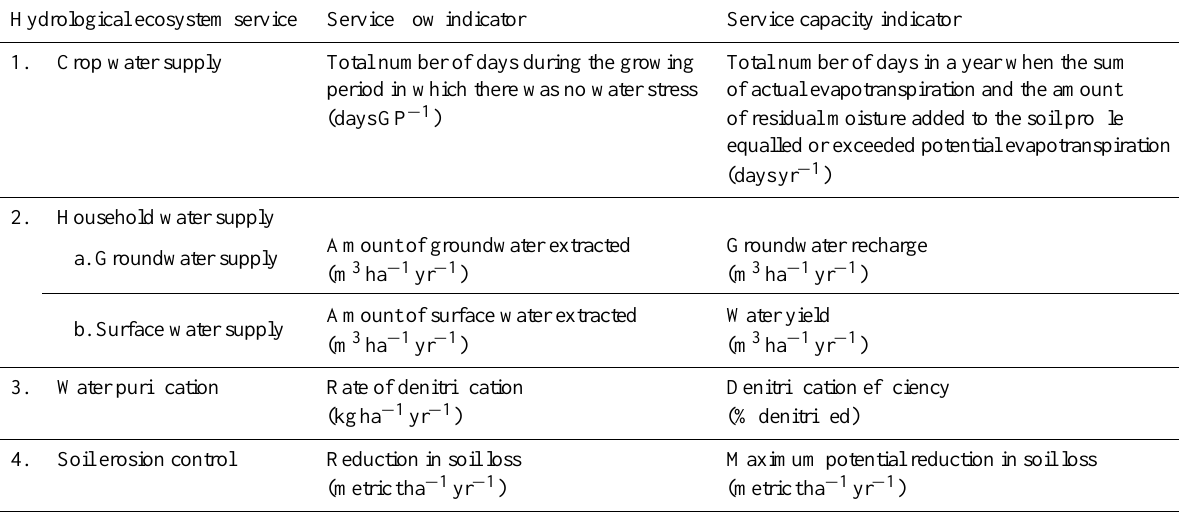
Table 2. Overview of selected hydrological ecosystem services and associated service flow and service capacity indicators (GP is growing period).